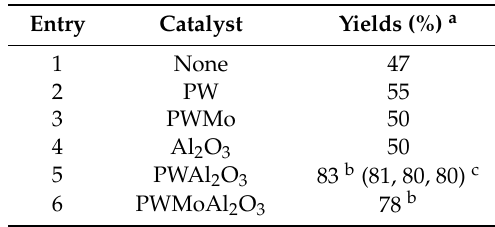
Table 7. Effect of different catalysts on product yields (%). Reaction conditions: 4-toluidine (1 mmol); acetonylacetone (1 mmol); catalyst (4 mg of active phase); solvent-free; temperature, 60 ◦ C; time 45 min; stirring.